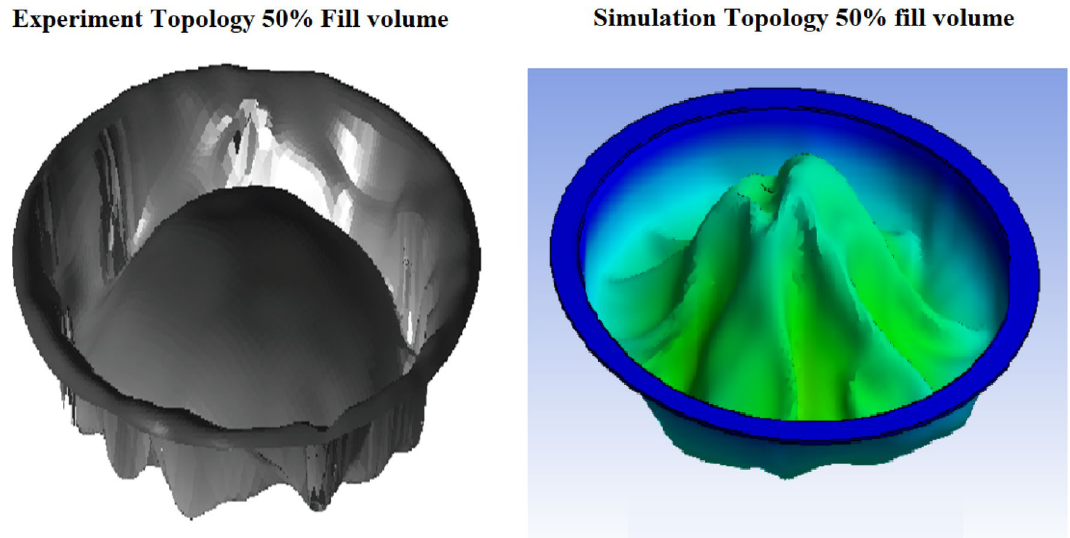
Fig. 22 The comparison of the results of numerical and experimental analysis considering the tensile force